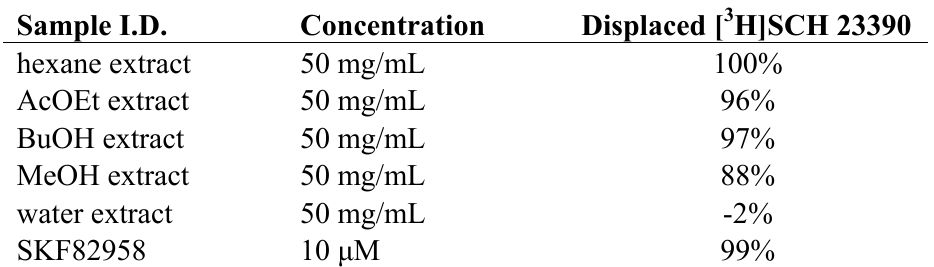
Table 1. Displacement of [ 3 H]SCH 23390 binding to membranes of CHO cells stably expressing the rD 1